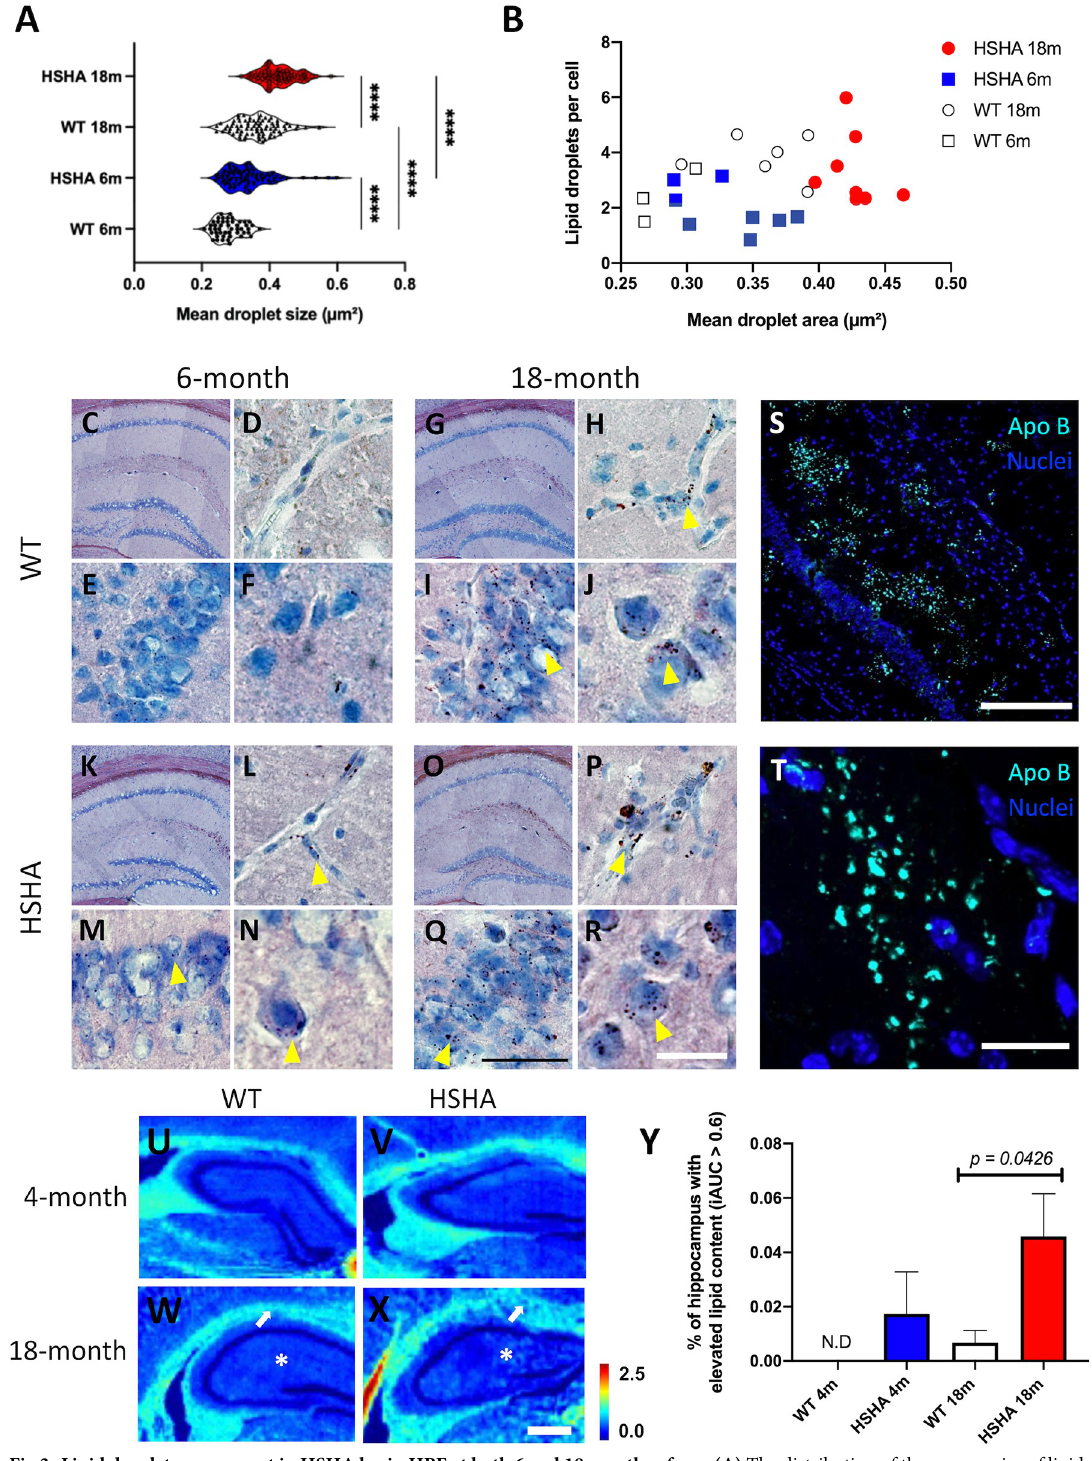
Fig 3. Lipid droplets are present in HSHA brain HPF at both 6 and 18 months of age. (A) The distribution of the average size of lipid droplets stained by Sudan IV lipid stain in the HPF of 6-month-old (blue) and 18-month-old (red) HSHA mice with their age-matched controls. Data are expressed as means; n = 4–8 mice with approximately 100 images analysed. Statistical significance was assessed with two-way ANOVA ( ���� p < 0.0001). (B) The Pearson AU : PleasenotethatasperPLOSstyle ; eponymictermsshouldnotbepossessive : Hence ; allinstancesofPearsonscorrelationcoefficienthavebeenreplacedwithPearsoncorrelationcoefficientthroughoutthetext : Pleasecheckandcorrectifnecessary : correlation coefficient of the mean area occupied by lipid droplets and number of lipid droplets per cell in the HPF region in young and aged HSHA and WT controls ( n = 4–8). (C, G, K, O) Representative bright field coronal micrographs of the HPF stained with Sudan IV in 6-month-old and 18-month-old HSHA mice and their age-matched WT